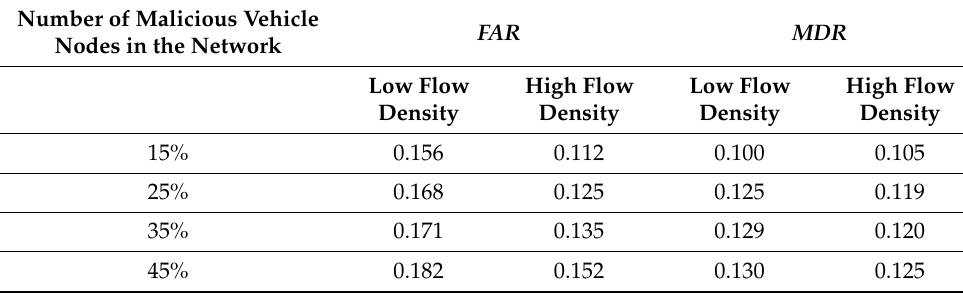
Table 4. Comparative results of the D, A, and O. Number of Malicious Vehicle Nodes in the